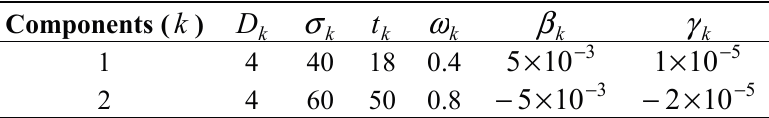
Table 1. Parameters of the simulated signal.